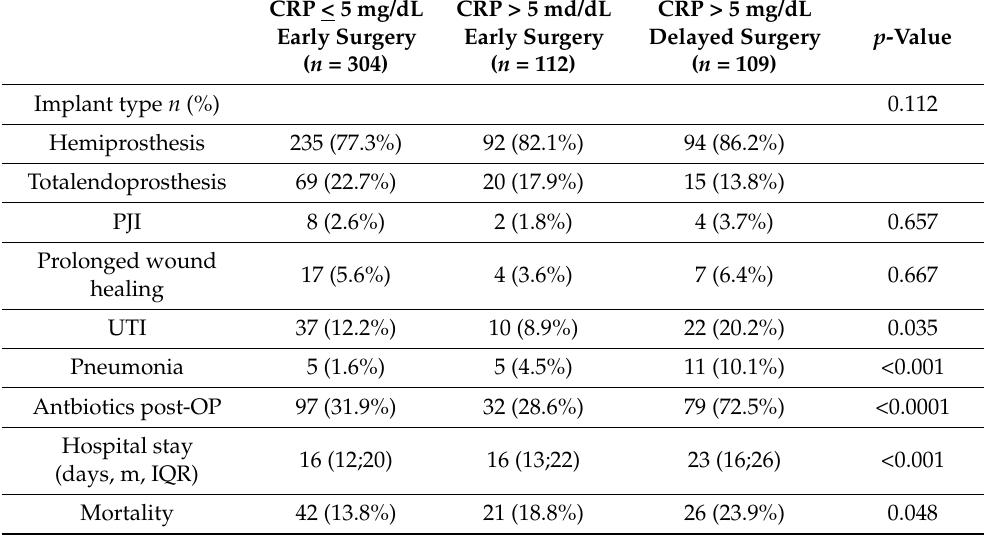
Table 3. Outcome